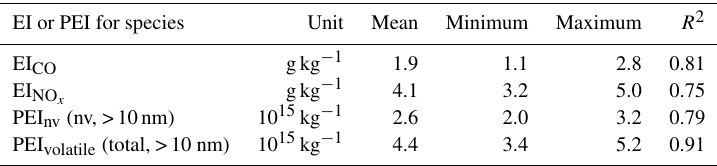
Figure A2. Time series (including time shifts as given in the text) of carbon dioxide (CO 2 , with precision error bar for every 10th value), nitrogen oxides (NO y ) , and carbon monoxide (CO) molar mixing ratios and concentrations n p of total and non-volatile particles with diameters >10nm for the RECONCILE plume self-encounter of 30 January 2010. Table A1. Emission indices derived from two self-encounters at 20 (17.7 to 21.7)min plume ages and Pearson correlation coefficients R 2 relative to CO 2 , 30 January